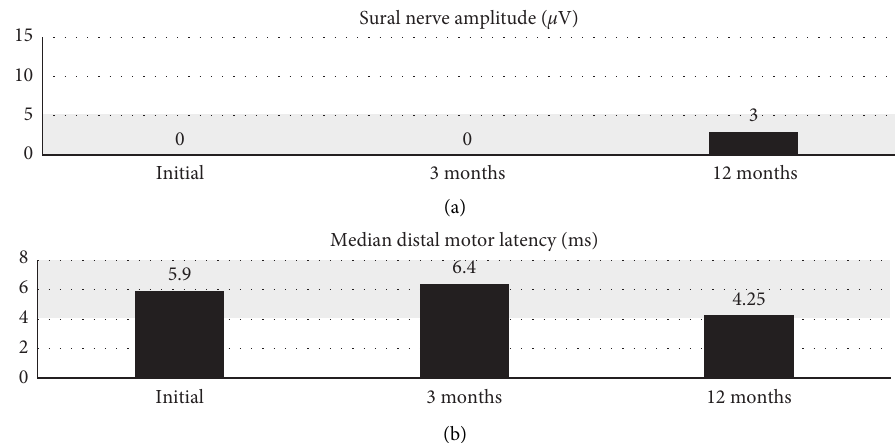
Figure 2: Serial nerve conduction values over time. (a) Sural nerve amplitude ( μ V). (b) Median distal motor latency